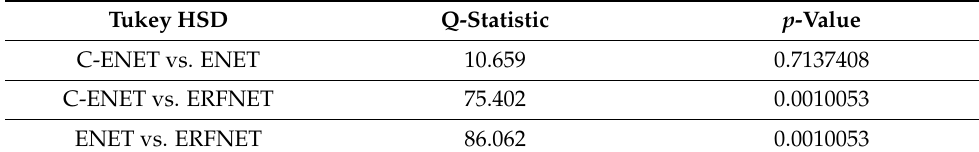
Table 4. Tukey HSD was used as a multiple comparison correction technique.